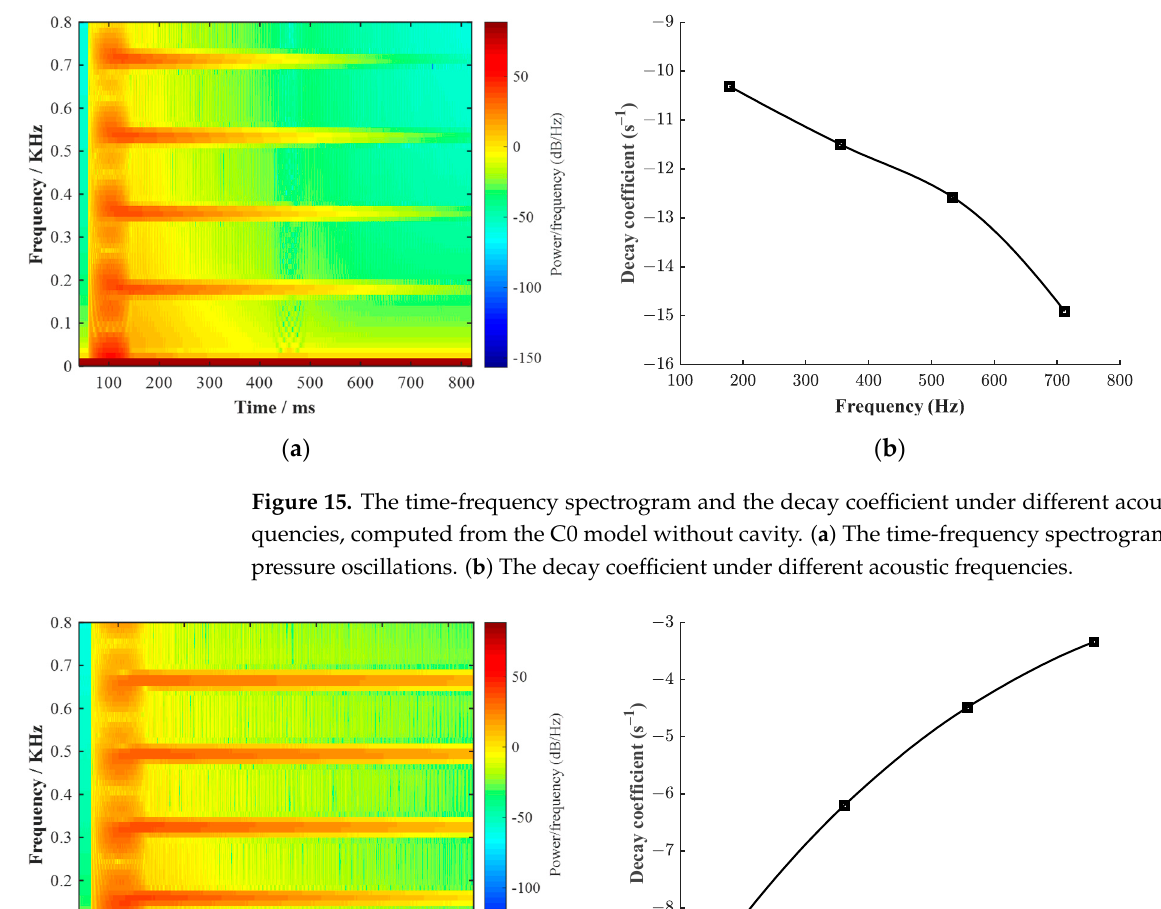
( b ) Figure 14. The decay coefficient and the axial velocity of motor under different gas temperature. ( a ) The decay coefficient under different working temperatures. ( b ) The axial velocity of motor under different gas temperatures. 4.6. The Effect of Frequency on Nozzle Damping When the chamber is excited by the pulse of a disturbance at the head end, multi ‐ mode damping due to the presence of several frequencies in the combustion chamber oc ‐ curs [30,43]. By filtering the pressure oscillation wave, the decay coefficients under certain frequencies can be obtained. In this section, case C0 is taken as an example to be studied. At first, removing the submerged cavity of the C0 model and other geometric parameters of the model remains unchanged; then it turns into a simple solid rocket motor model. According to the numer ‐ ical method and the data processing method described above, the time ‐ frequency spec ‐ trogram of pressure oscillations and the decay coefficient under different frequencies are illustrated in Figure 15. It can be seen in Figure 15a that the pressure oscillation occurs at 100 ms when the chamber is excited by a pulse and the pressure oscillation is dominated by several axial acoustic modes. After filtering the pressure oscillation wave, the oscilla ‐ tions dominated by the first four axial acoustic modes are obtained and processed sepa ‐